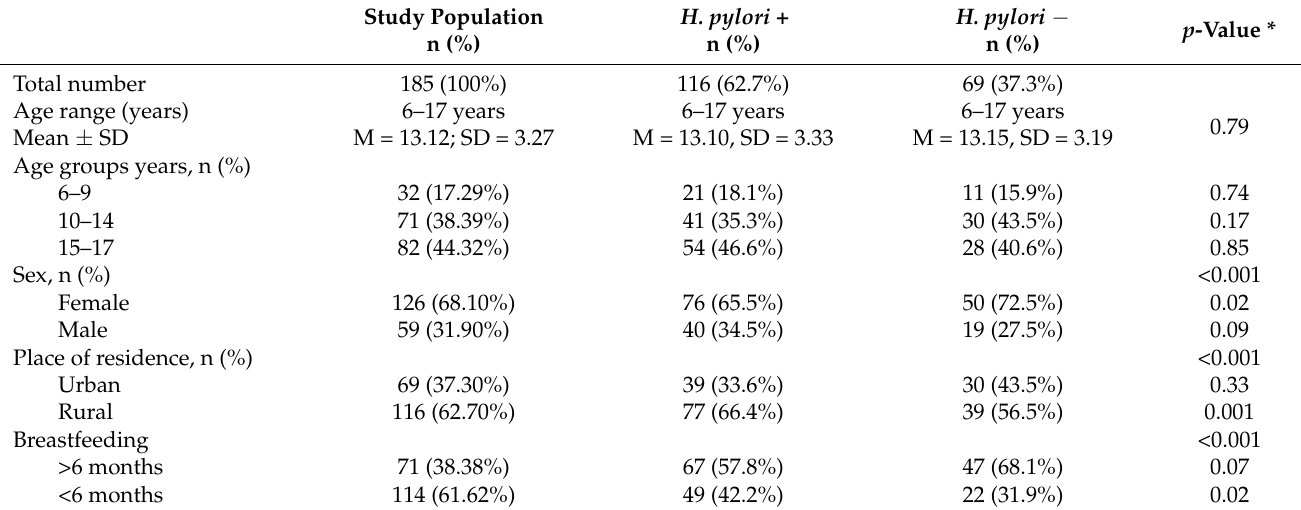
Table 1. Study population characteristics.